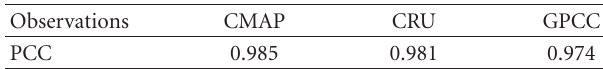
Table 3: Spatial pattern correlation coe ffi cient (PCC) over West Africa from CMAP, CRU, and GPCC rainfall with respect to GPCP. Observational datasets (CMAP, CRU, and GPCC) are interpolated to GPCP